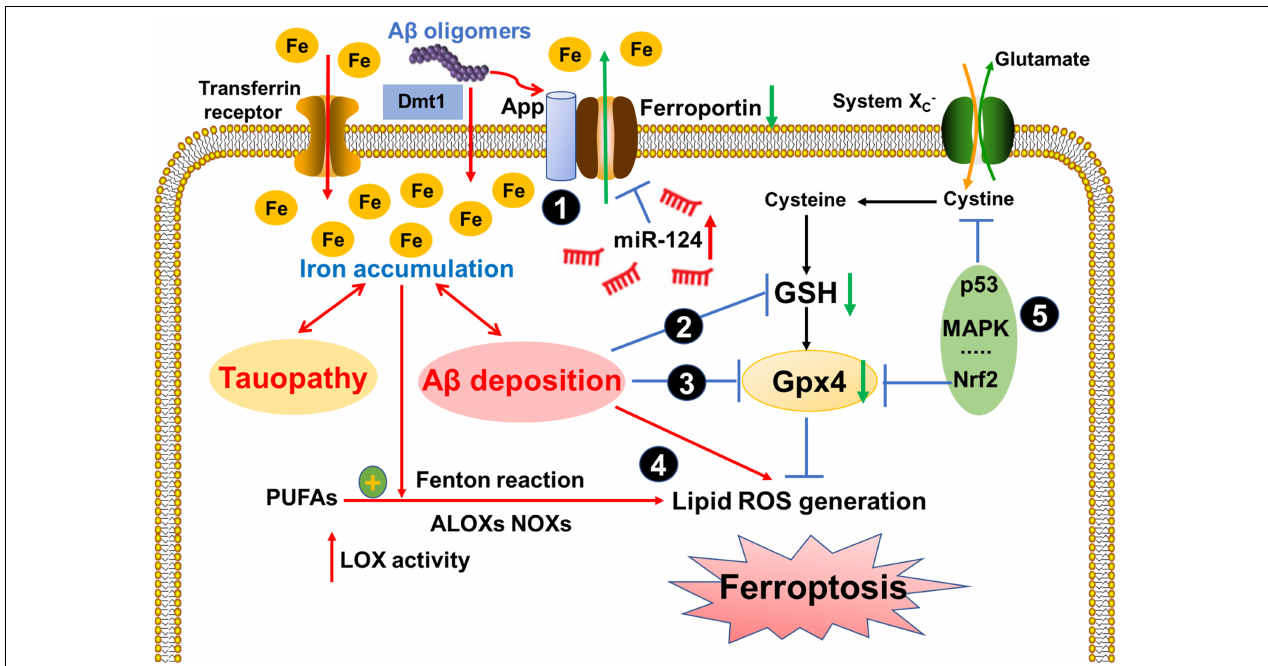
FIGURE 2 | Ferroptosis-related signaling pathways in